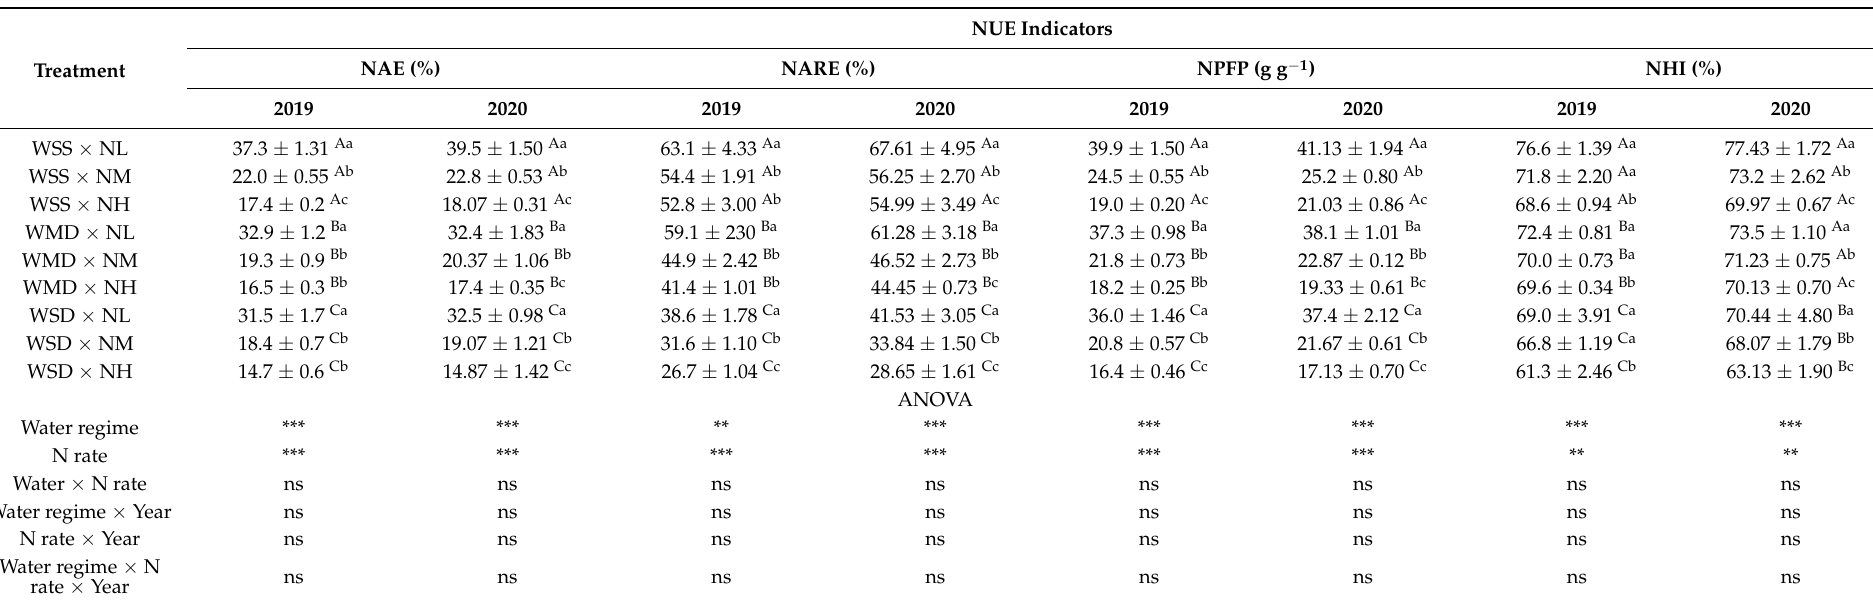
Table 5. Mean values of the NUE indicators of rice for different irrigation techniques and N fertilizer rates, and a summary of the ANOVA analysis of the impacts of irrigation regimes and N fertilizer rates on the NUE indicators of